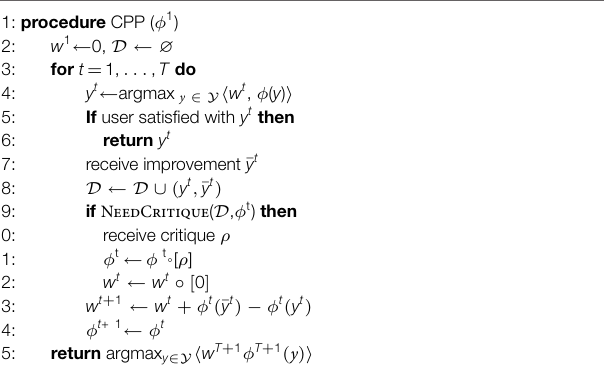
Algorithm 4 | The Critiquing Preference